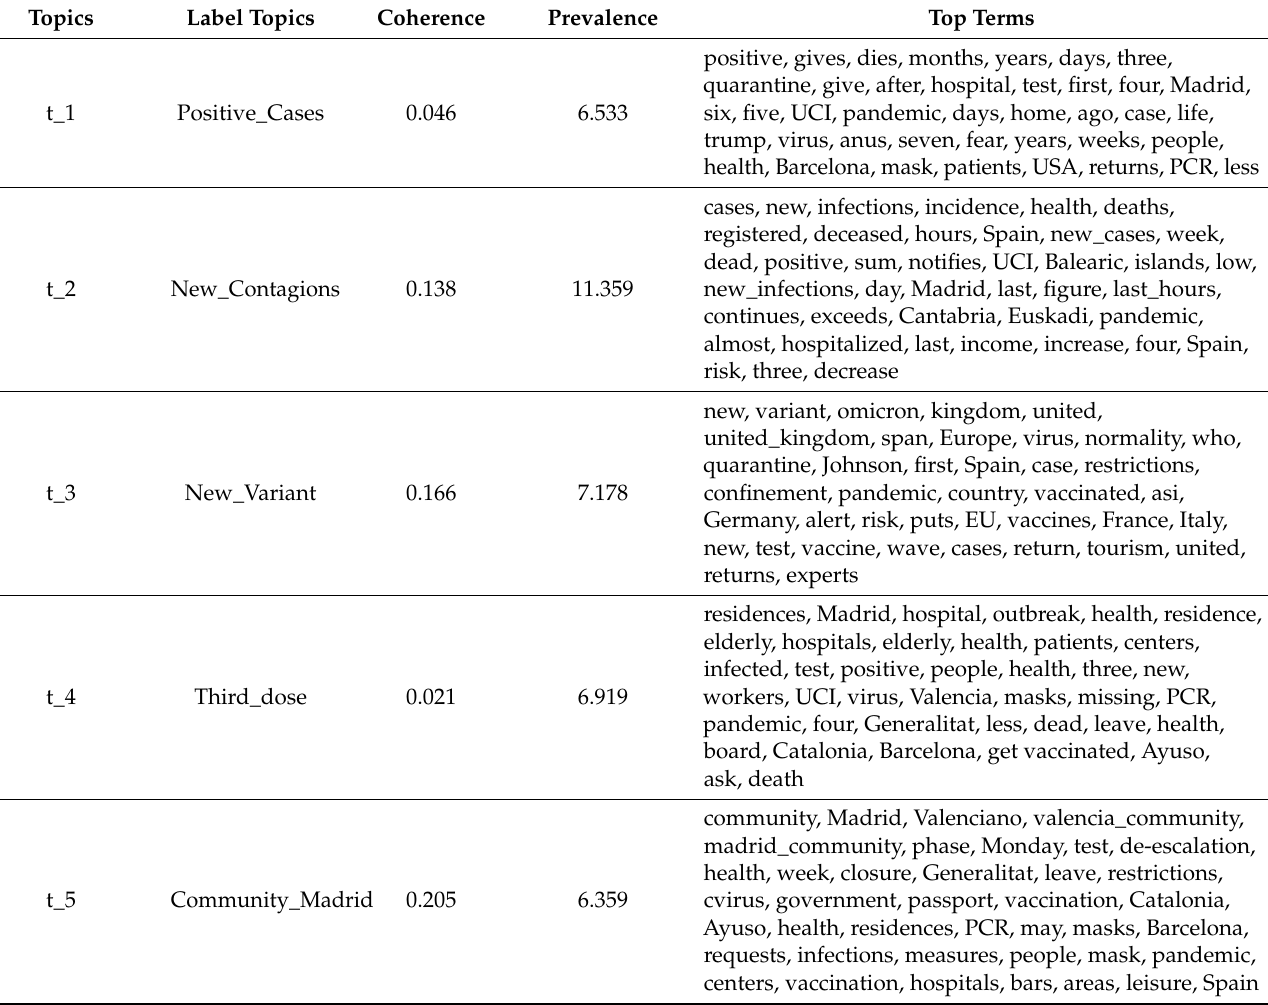
Table A1. Topics, label topics, coherence, prevalence, and top term of the model